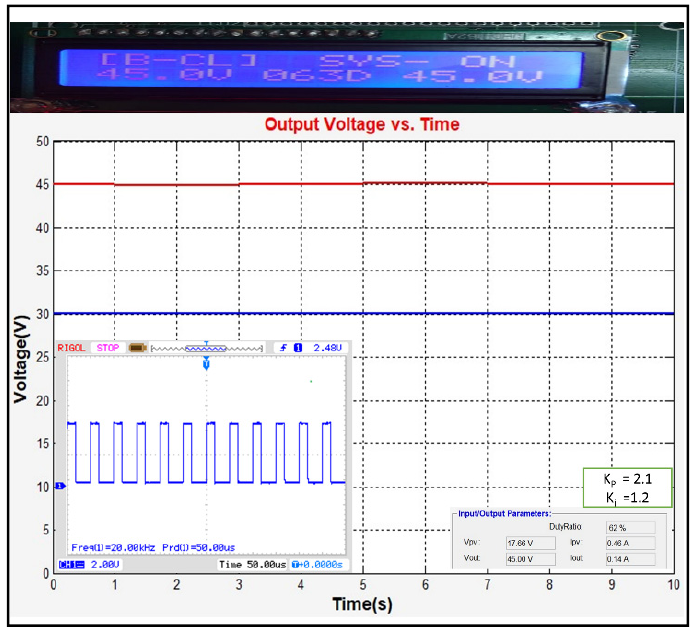
Figure 16. Results of boost convertor with the duty of 63% for the closed-loop system.